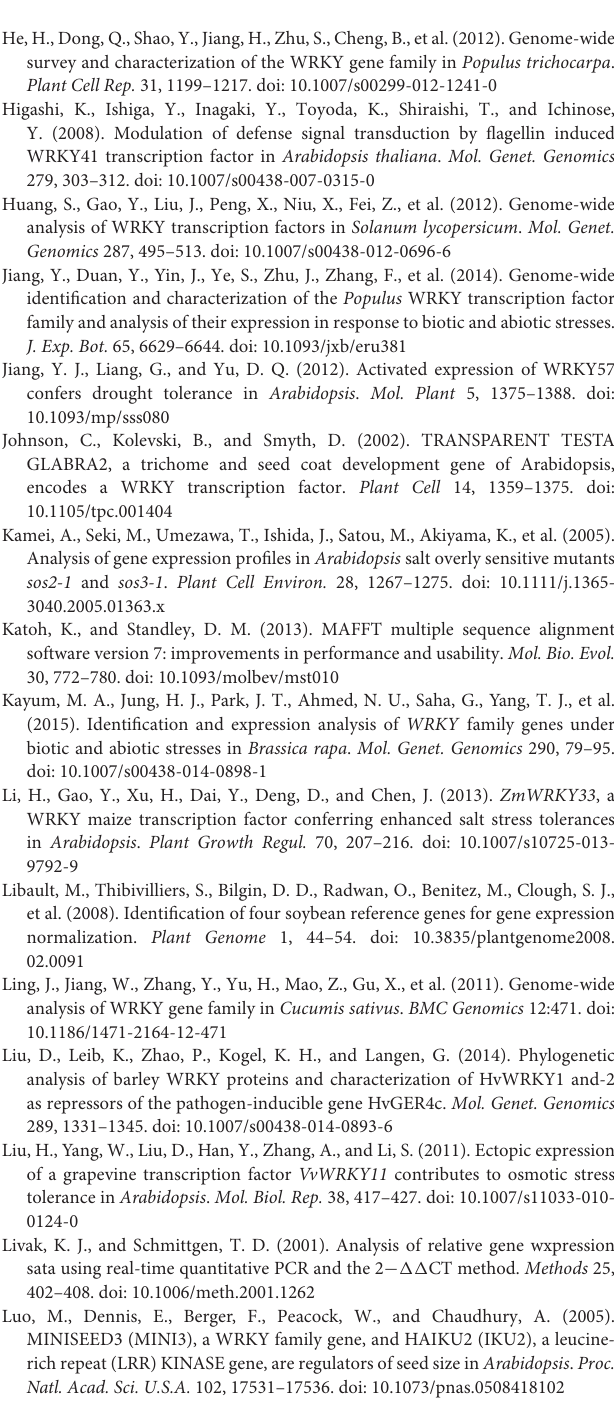
Table S7 | cis -element in differentially expressed genes of dehydration. Table S8 | cis -element in differentially expressed genes of salt. Figure S1 | Phylogenetic tree of AtWRKY and GmWRKY domain. The phylogenetic tree was constructed using MAGE 6.0 by the Neighbor-Joining (NJ) method with 1000 bootstrap